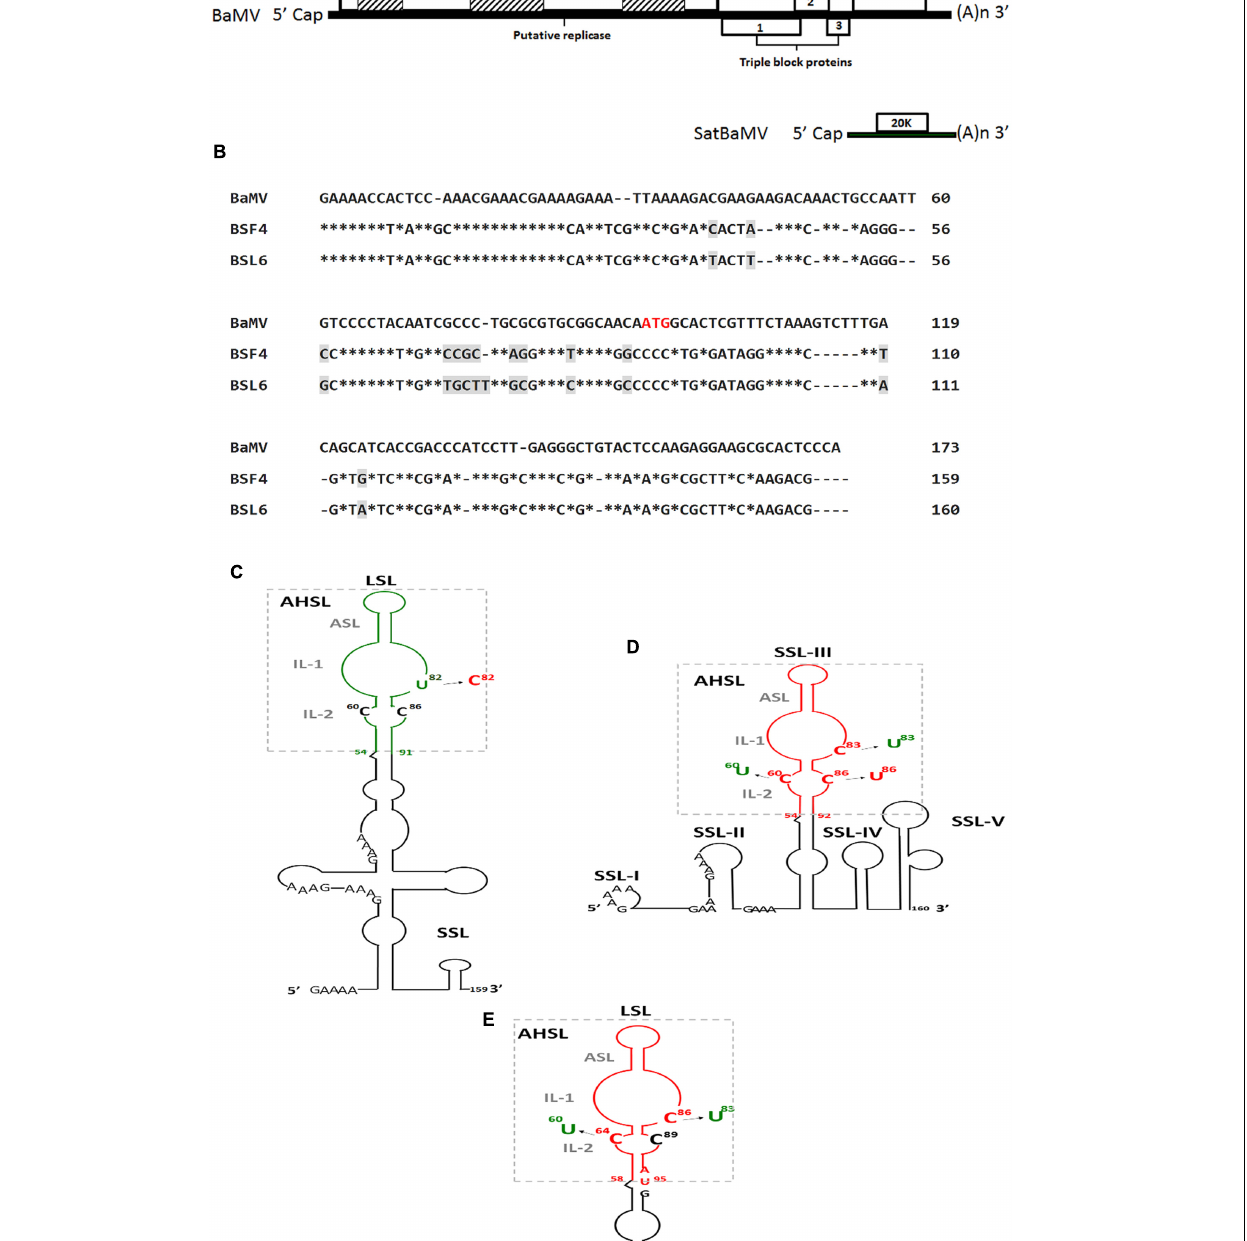
Frontiers in Microbiology |